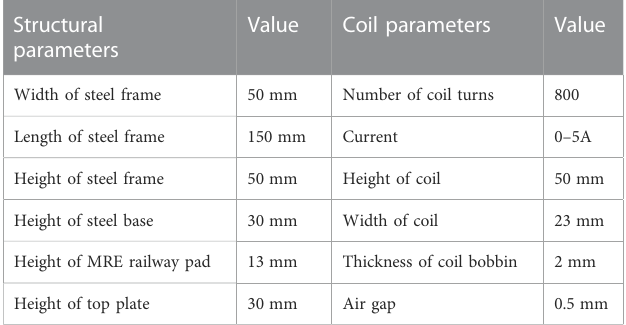
TABLE 2 Structural parameters of magnetic controlling unit.